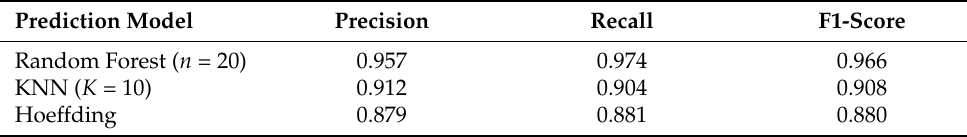
Table 1. Experimental results for the prediction of the delivery success. Prediction Model